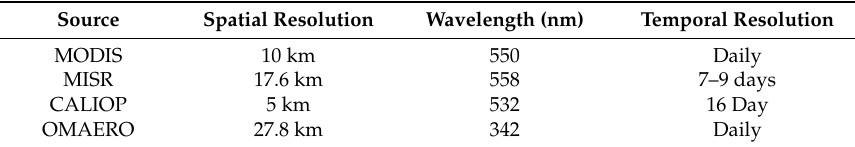
Table 1. Spatial and temporal resolution of satellite AOD products used in the